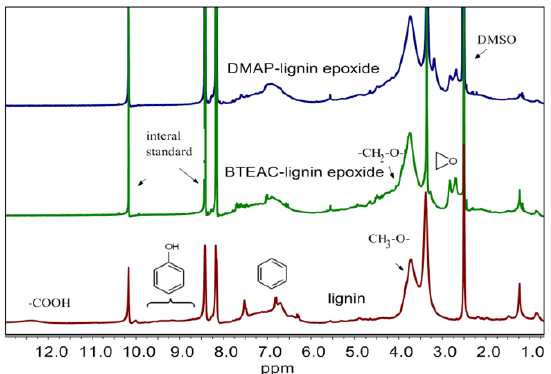
Figure 2. 1 H-NMR spectra of the lignin, DMAP-lignin epoxide, and BTEAC-lignin epoxide. p -NBD Figure 2. 1 H nuclear magnetic resonance ( 1 H-NMR) spectra of the pristine lignin, DMAP-lignin epoxide, and BTEAC-lignin epoxide. p -nitrobenzaldehyde ( p -NBD) was adopted as the internal was adopted as the internal standard, with the characteristic 1 H-NMR peaks at 8.10–8.20, 8.30–8.50, standard, with the characteristic 1 H-NMR peaks at 8.10–8.20, 8.30–8.50, and 10.10–10.20 ppm. and 10.10–10.20